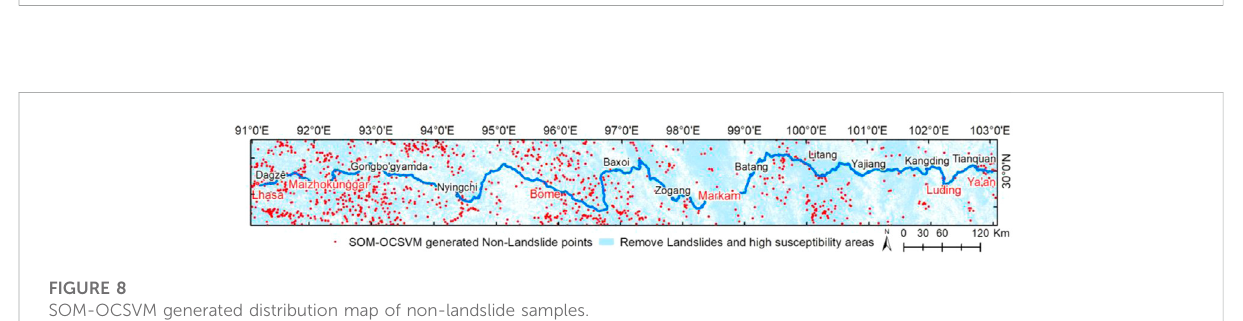
FIGURE 8 SOM-OCSVM generated distribution map of non-landslide samples.